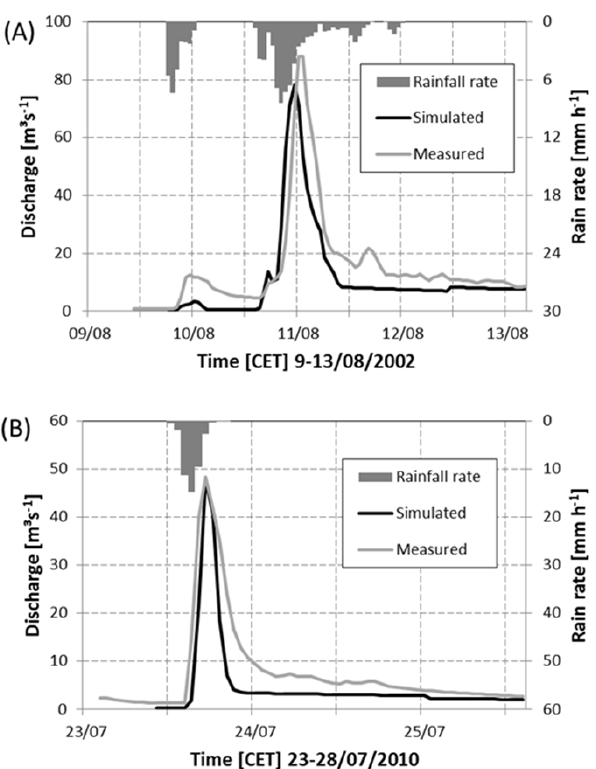
Fig. 10. Comparison between observed and simulated hydrograph at Rangendingen for two flood events occurred on: (a) 11 August 2002 and (b) 23 July 2010.